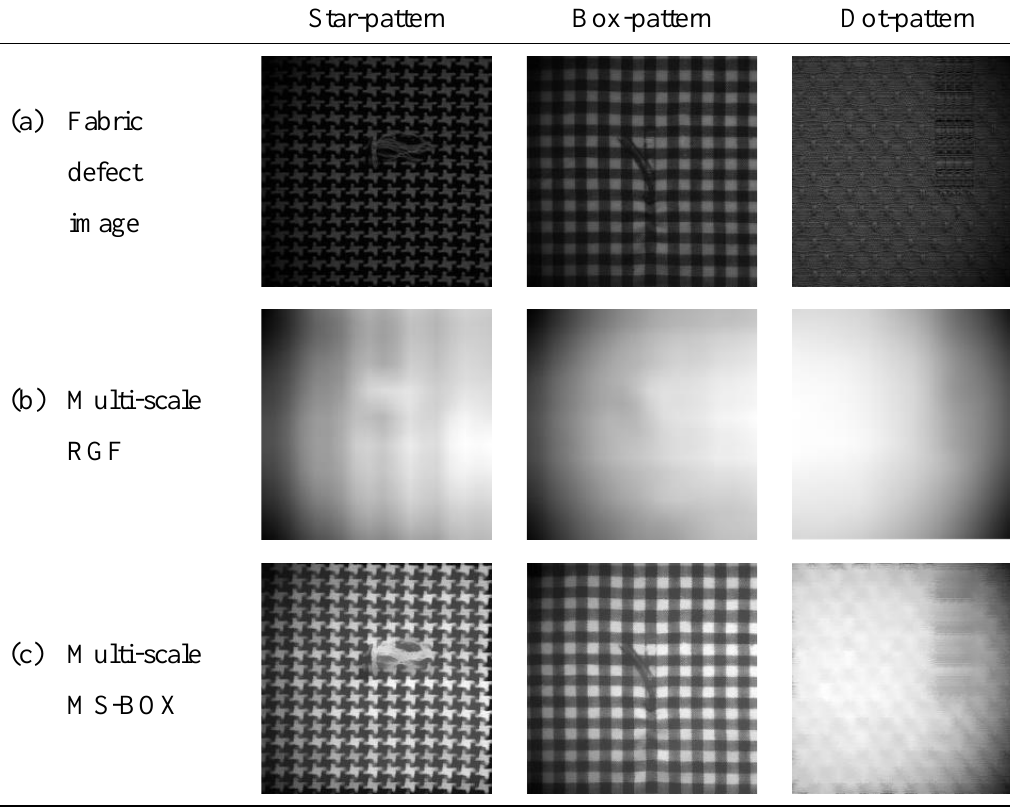
Figure 6. Comparison of illumination component extraction